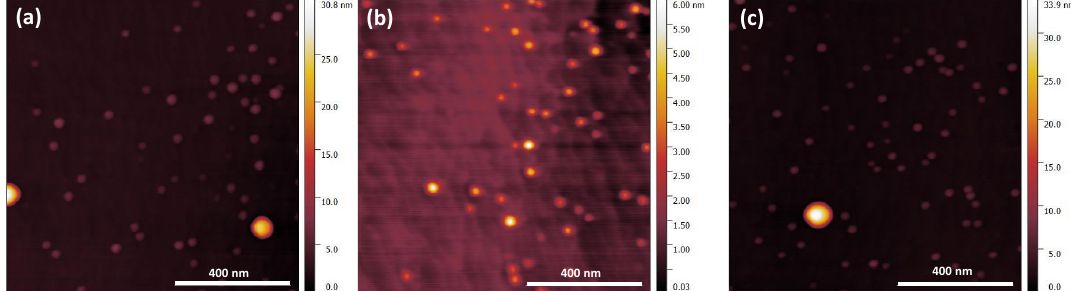
Figure 3. The 1 µ m × 1 µ m AFM images of uncapped InAs / GaAs QDs grown on a Ge / Si 300mm substrate: ( a ) the center; ( b ) the mid-radius; and ( c ) close to the edge.